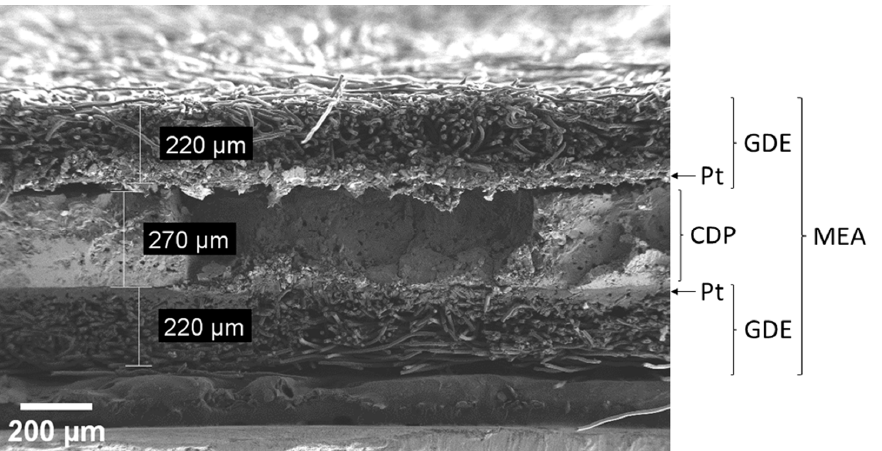
Figure 10. Representative scanning electron micrograph of a cross-section from a symmetrical membrane electrolyte assembly (MEA) consisting of a dense CsH 2 PO 4 (CDP) electrolyte pellet in the center and two identical gas diffusion electrodes (GDEs) including a platinum thin film (Pt) on each